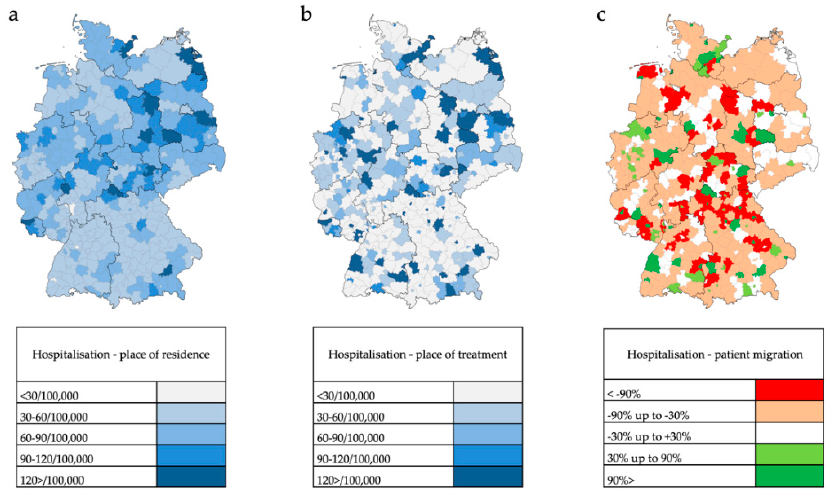
Figure 6. PD (G20+G21+G23) inpatient treatment in 401 administrative counties in Germany in the